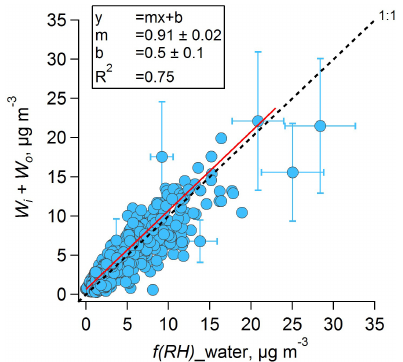
Figure 9. Comparison between total predicted and measured water Figure 8. pH predictions by perturbing RH compared to pH at base by nephelometers based on hourly averaged data at CTR (SOAS). level. W i , W o , and H + were recalculated based on ± 5 and ± 10% air An ODR fit was applied. Error bars for selected points are original RH to investigate pH uncertainty. The slopes and R 2 indi- cate pH uncertainty caused by RH.